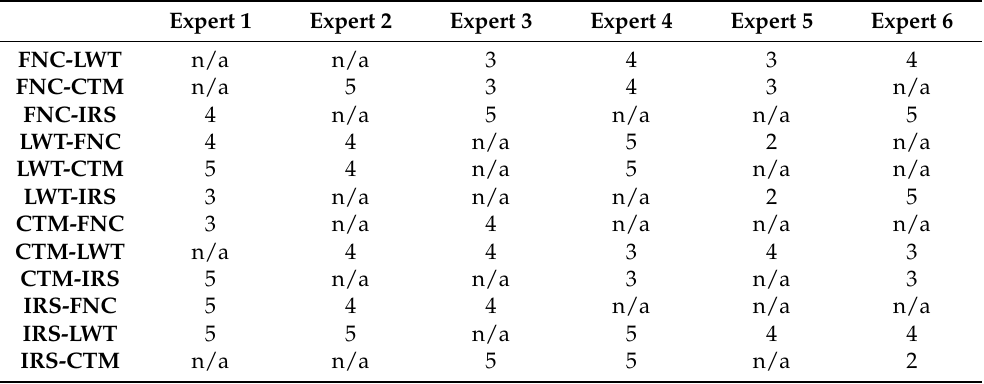
Table A2. The preference ratings of the experts for the relation matrix of perspectives.